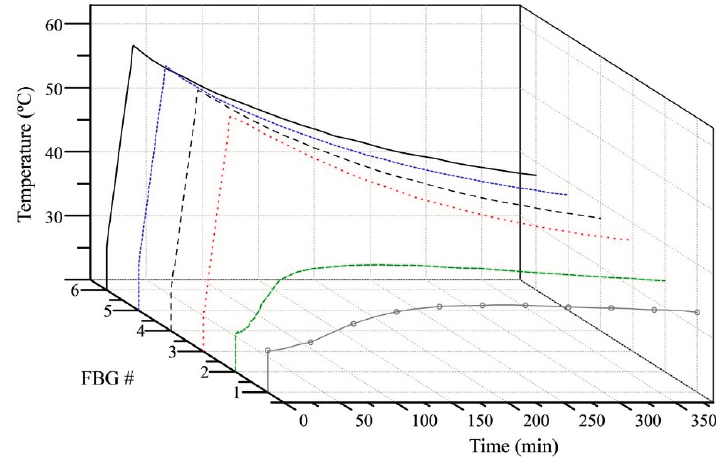
Figure 10. Temperature evolution along heating and cooling cycles for the quasi-distributed temperature